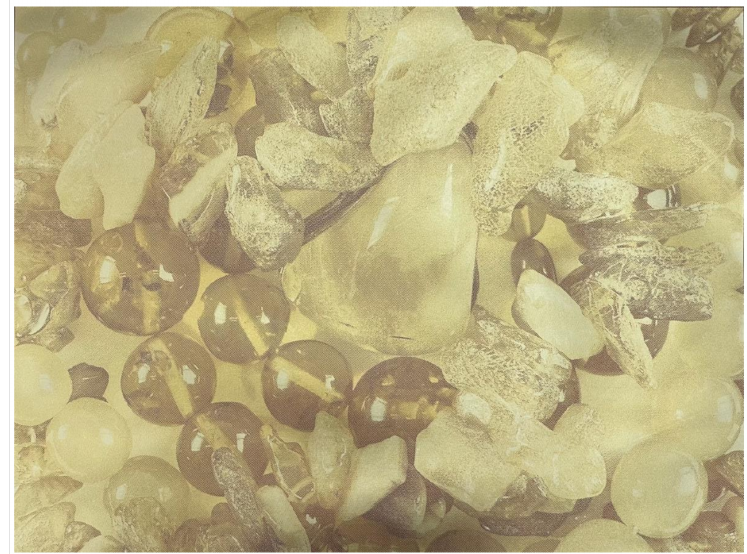
Figure A16. 25LPI, C = Pyrisma™ Ambercup Orange, B = Iriodin™ Solar Gold, M = Iriodin™